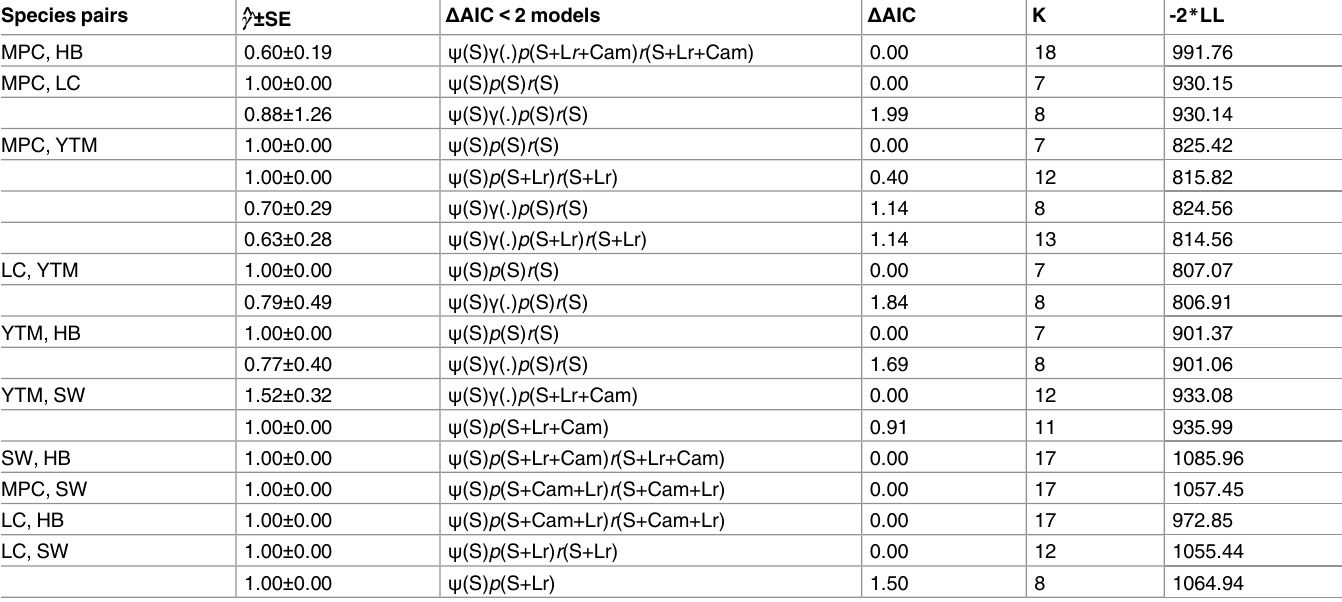
Table 3. Top models and estimation of species interaction factor (SIF, ^ γ ^ ) for each species pair from two species occupancy modeling. The spe- cies abbreviations of species’ names are LC-leopardcat, MPC-masked palm civet, HB-hog badger, SW-Siberian weasel, and YTM-yellow-throated marten. K is the number of estimated parametersin the model and Δ AIC is the absolute differencein AIC values relative to the model with the smallest AIC. The term “S” in parentheses denotes that the occupancy probabilityor detection probability of species were estimated separatelyfor each species, and “ (cid:1) ” indicates that the parameter is constant. Absence of γ ( (cid:1) ) in the model notation implies that γ = 1 and absence of r (S) implies r (S) = p (S). “Lr” refers to scent lure persis- tence; and “Cam” refer to camera trap models.